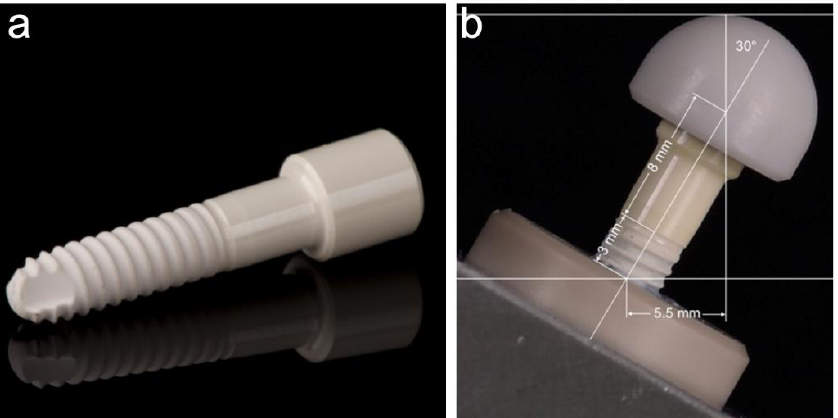
Figure 1. ( a ) Evaluated implant made of a ceria-stabilized zirconia-alumina-aluminate composite (Ce-TZP-comp), ( b ) embedding of the implants according to ISO 14801.